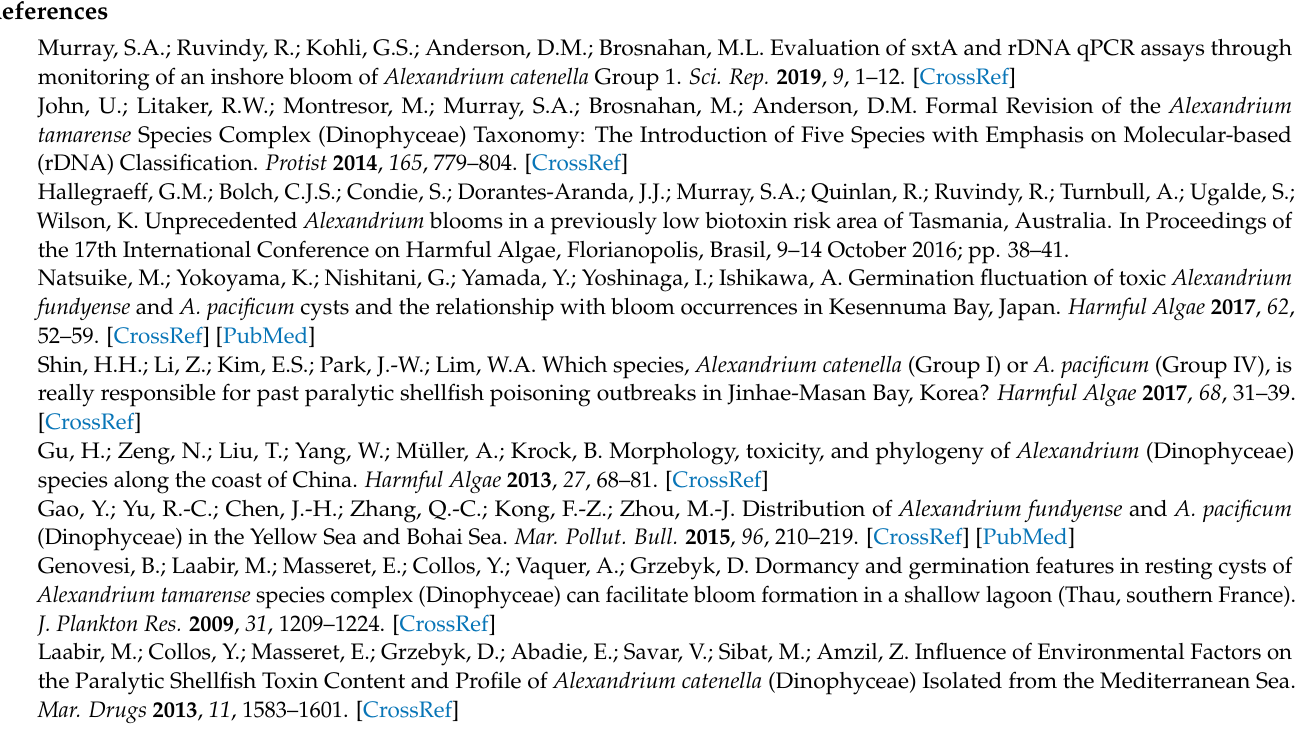
.3390/w13192681/s1: Supplementary Figure S1: Gene-based calibration curves. AE, amplification efficiency. Supplementary Figure S2: Cell-based calibration curves. AE, amplification efficiency. Supplementary Figure S3: Determination of extractable gene copies per cell from the slope of the linear regression of LSU gene copies versus cell densities of Alexandrium pacificum based on mi- croscopic cell counts. The mean extractable LSU copy numbers per cell was 168,550 ± 18,780. Supplementary Figure S4: Correlation between the number of spiked cells based on microscopic cell counts and the estimated number of cells determined by the qPCR assay. Supplementary Table S1: Sampling information of water and sediment samples in the Taiwan Strait. Supplementary Table S2: Sampling information of water samples of the three fixed stations in Xiamen Bay for qPCR. Supple- mentary Table S3: Sampling information of water samples of the 17 stations in Dongshan Bay for qPCR. Supplementary Table S4: DNA extraction efficiency of the NucleoSpin Soil kit. Supplementary Table S5: Toxin profiles of Alexandrium pacific strains from different sea